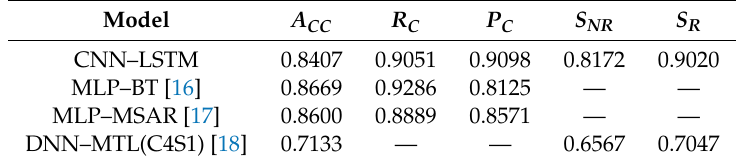
Table 4. Comparison of evaluation indexes with models in other research